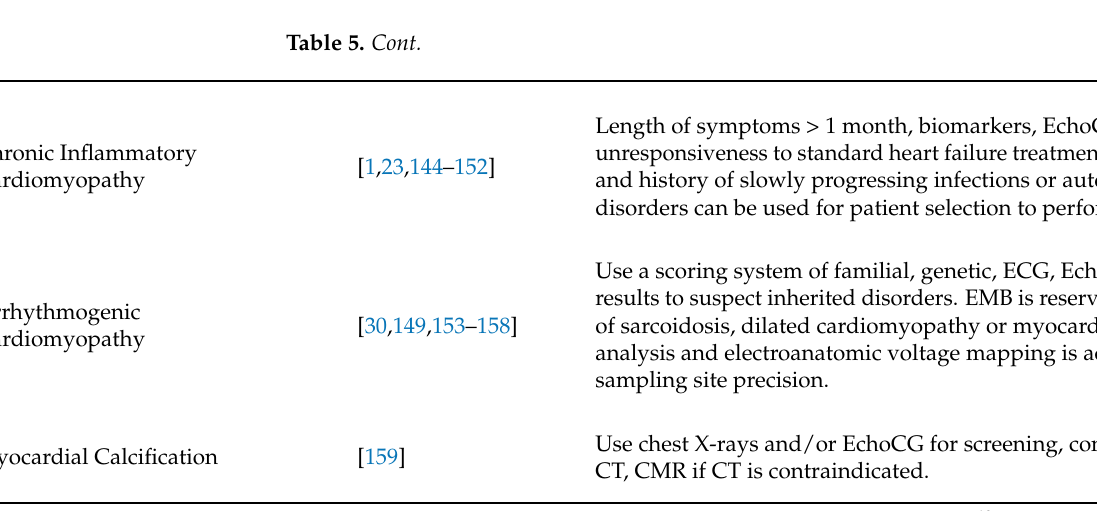
Abbreviations in the table: CMR, cardiac magnetic resonance; FDG PET/CT, 18 F-fluorodeoxyglucose Positron Emission Tomography/Computed Tomography; EMB, endomyocardial biopsy; SLEDAI, Systemic lupus erythe- matosus disease activity